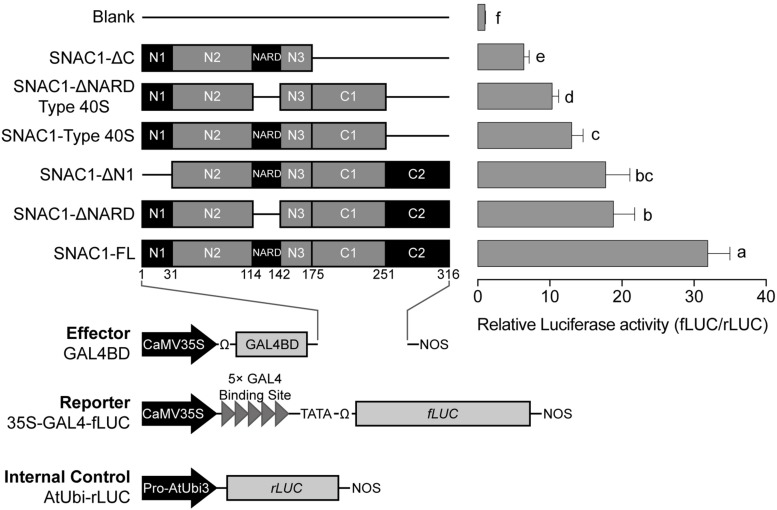
Full (SNAC1-FL) or partial (SNAC1-ΔC, SNAC1-ΔNARD Type 40S, SNAC1-Type 40S, SNAC1-ΔN1, SNAC1-ΔNARD) length of the SNAC1 fragments fused with the firefly luciferase reporter were tested for transactivation activity. The deletions are shown in lines. The left panel in the figure shows the structure of each vector, and the right panel shows the fLUC/rLUC activity ratio in the protoplasts. The ratio obtained from the transfection of the blank vectors (Blank) was set arbitrarily as 1. Error bar indicates the standard deviation (SD) of three independent replicates. Different letter(s) beside each column indicates the significant difference calculated via the Least Significant Difference (LSD) method (α = 0.05).